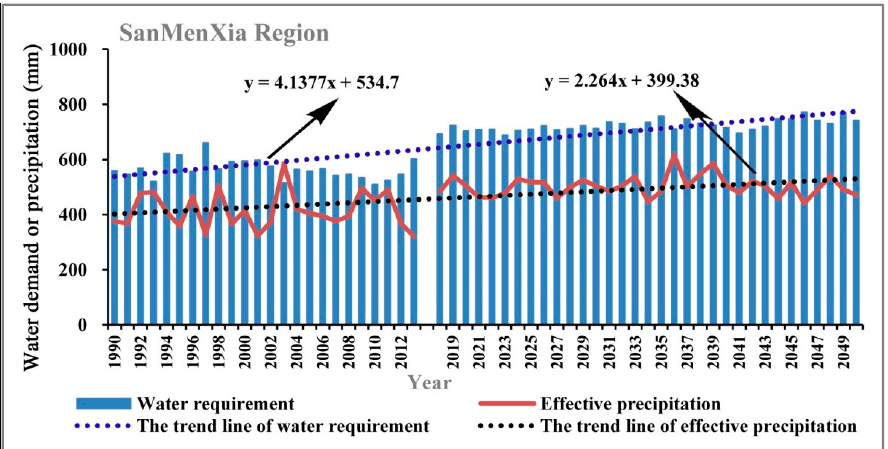
Figure 9. The changing trend of the water demand of apple trees and the effective precipitation in Sanmenxia Region in the periods of 1990–2013 and 2019–2050.